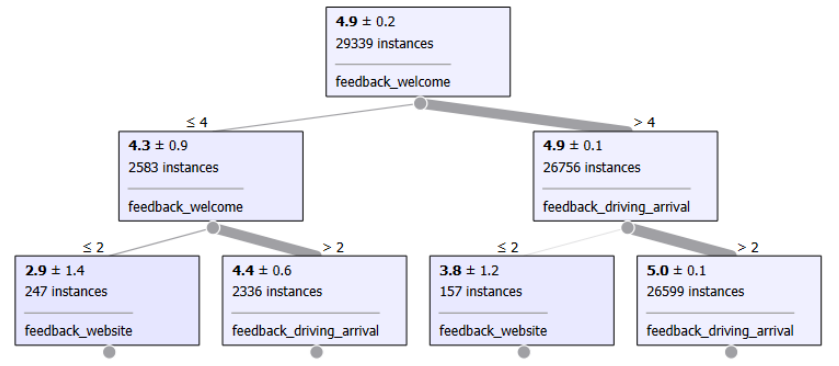
Figure 3. Decision tree results .